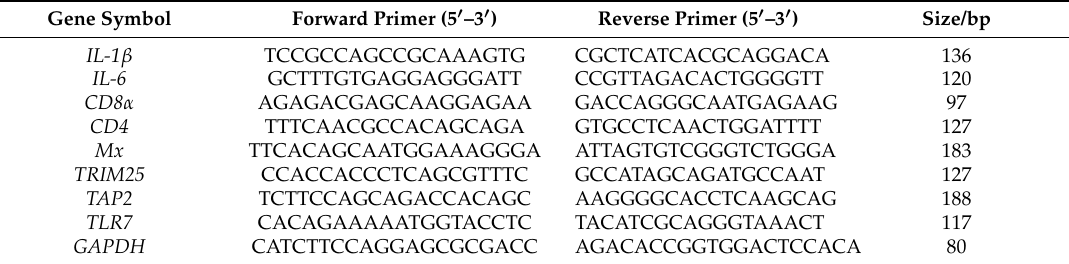
Table 2. Primers used for RT-qPCR